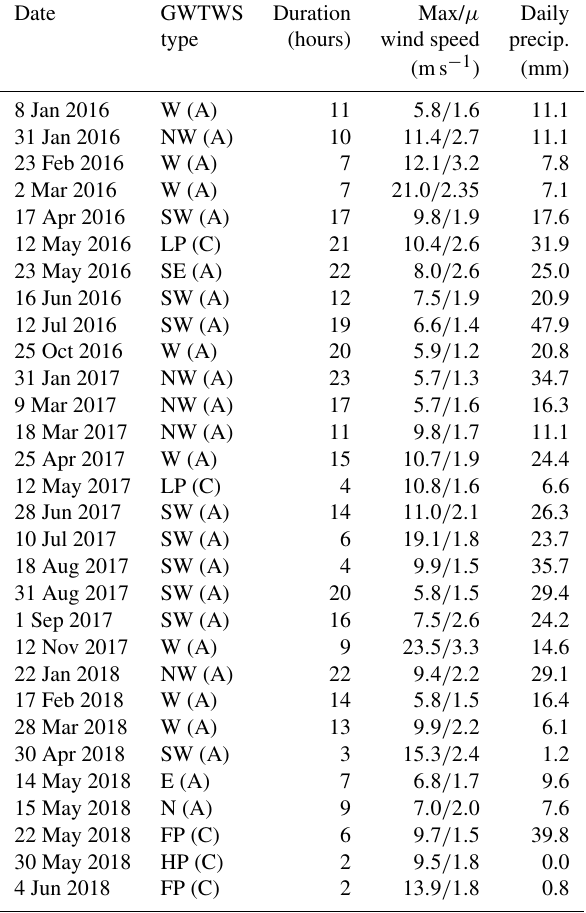
Table 2. Statistics for the precipitation events used in this study. Daily precipitation accumulations and wind speeds are from the Cham ground station at approximately 15km distance from the Al- bis radar. The GWTWS weather type classification, which is the adapted Grosswettertypes (GWTs) correlated with predefined “pro- totype” classes, is also shown (more details in Weusthoff, 2011). LP, HP and FP represent high-pressure, low-pressure and flat-pressure situations, respectively; the other acronyms are abbreviations of GWTWS flow directions. The letters A and C indicate advective or convective